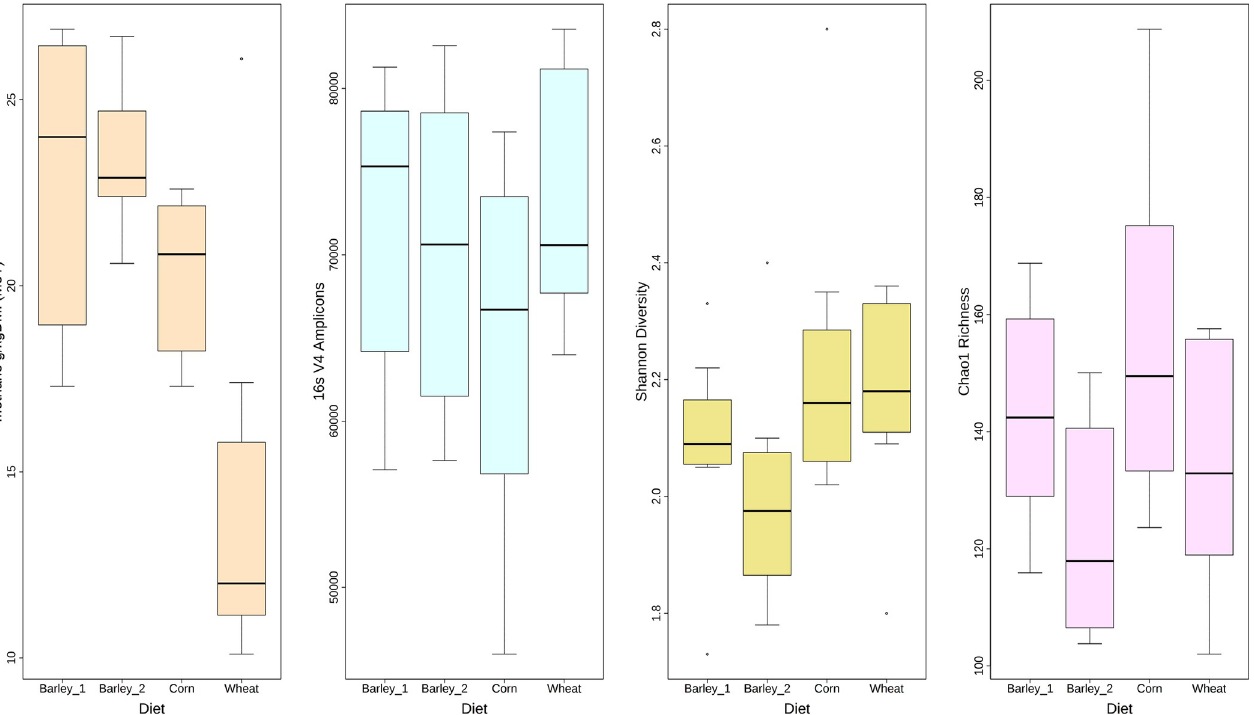
Fig 1. Boxplots illustrating distributions of MeY, 16s amplicon abundance, Shannon diversity and Chao1 richness compared to diet across the herd of 32 cows.